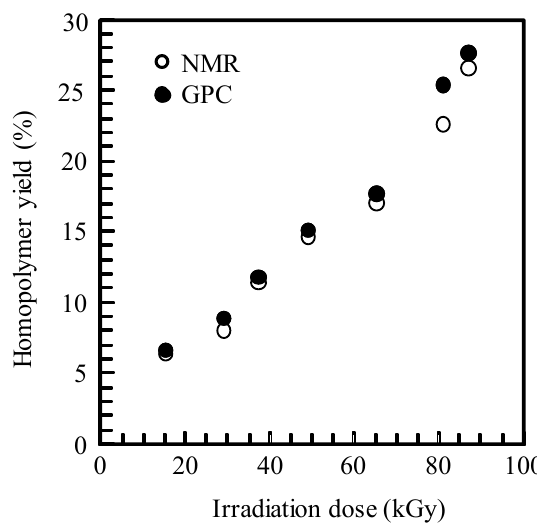
Figure 2. Homopolymer yield in the irradiated monomer solution determined by NMR and GPC methods as a function of the total irradiation dose. Dose rate, 1.0 kGy/h; [RAFT]/[CMS], 0.014; room temperature.